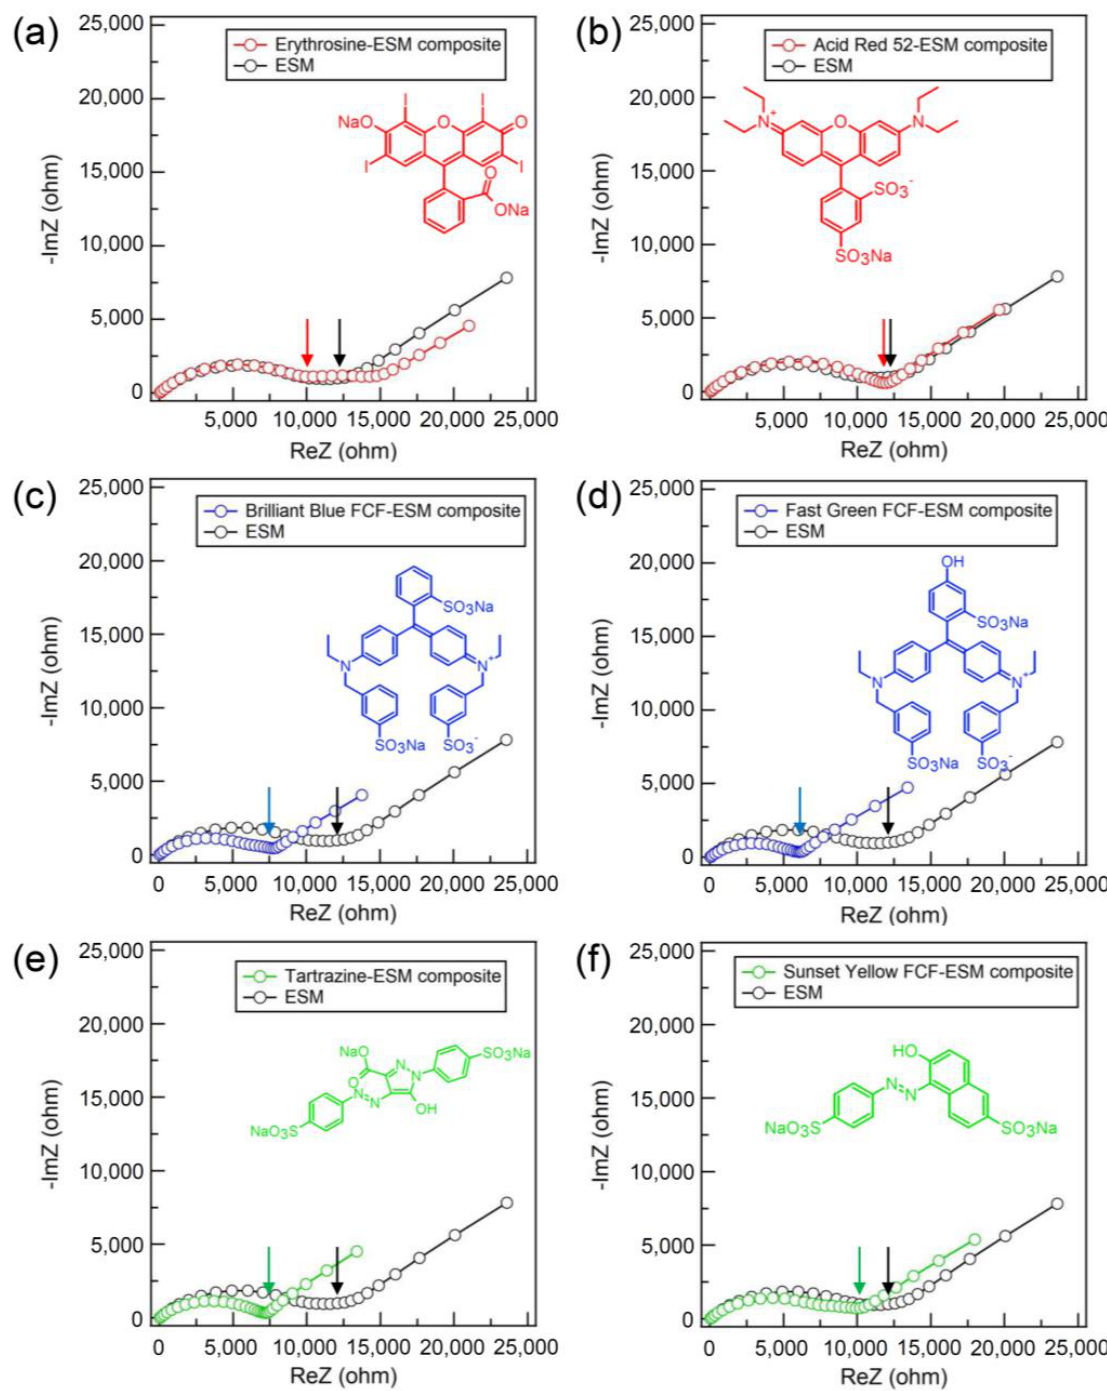
Figure 4. The Nyquist plots of the dye-ESM composites and the pristine ESM. The arrow points the charge transfer resistances R of each ESM. Xanthene-type (red): erythrosine ( a ) and Acid Red 52 ( b ); triphenyl-type (blue): Brilliant Blue FCF ( c ) and Fast Green FCF ( d ); azo-type (green): Tartrazine ( e ) and Sunset Yellow FCF ( f ).